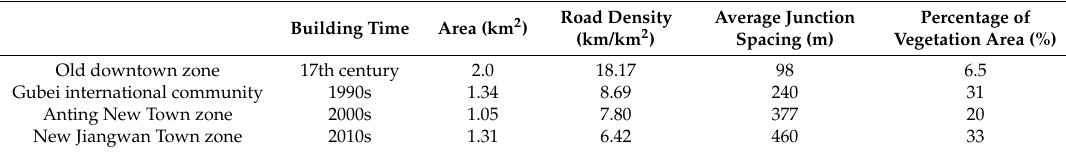
Table 1. The status of the building environment and streetscape fabric in the four